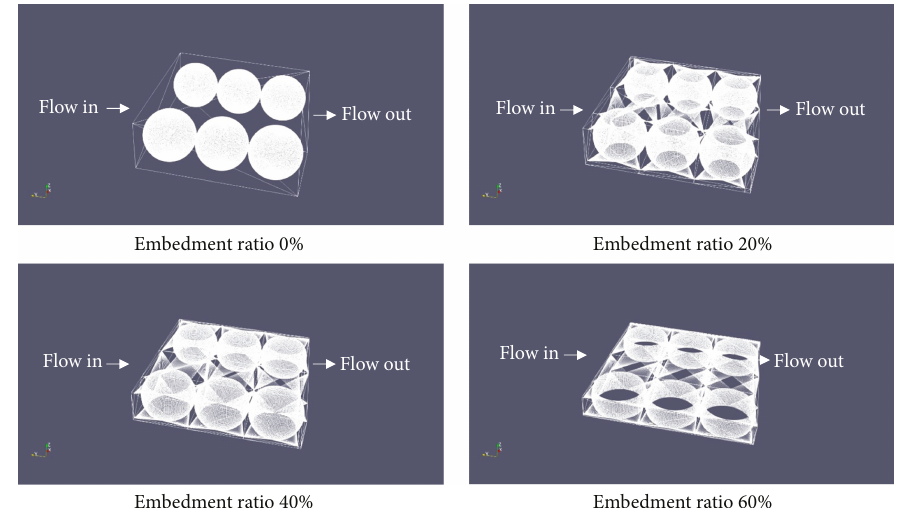
Figure 11: Illustration of di ff erent embedment ratios for distribution (a) in Figure